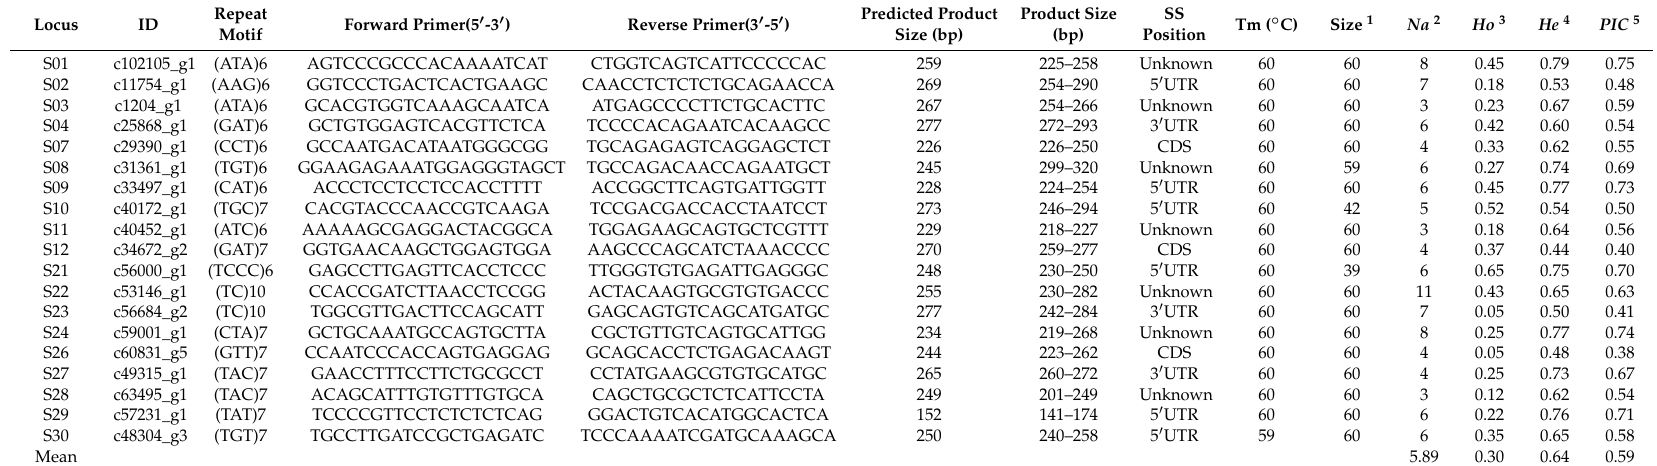
Table 4. Characteristics of 19 SSR (simple sequence repeat) markers developed from D. odorifera transcriptome and summary statistics of polymorphism transferred across three Dalbergia